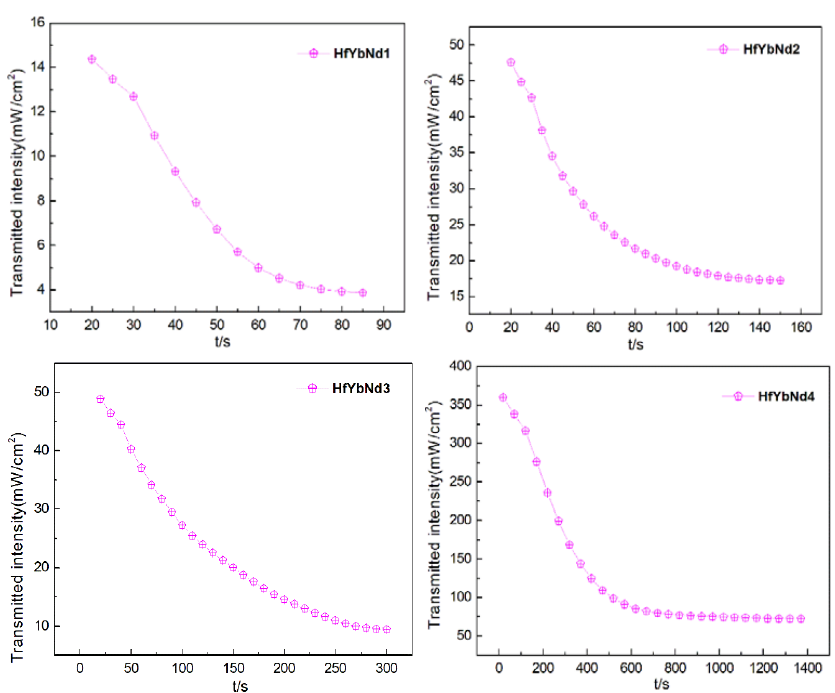
Figure 4. Exposure time dependence on the transmitted intensity of Hf:Yb:Nd:LiNbO 3 crystals.